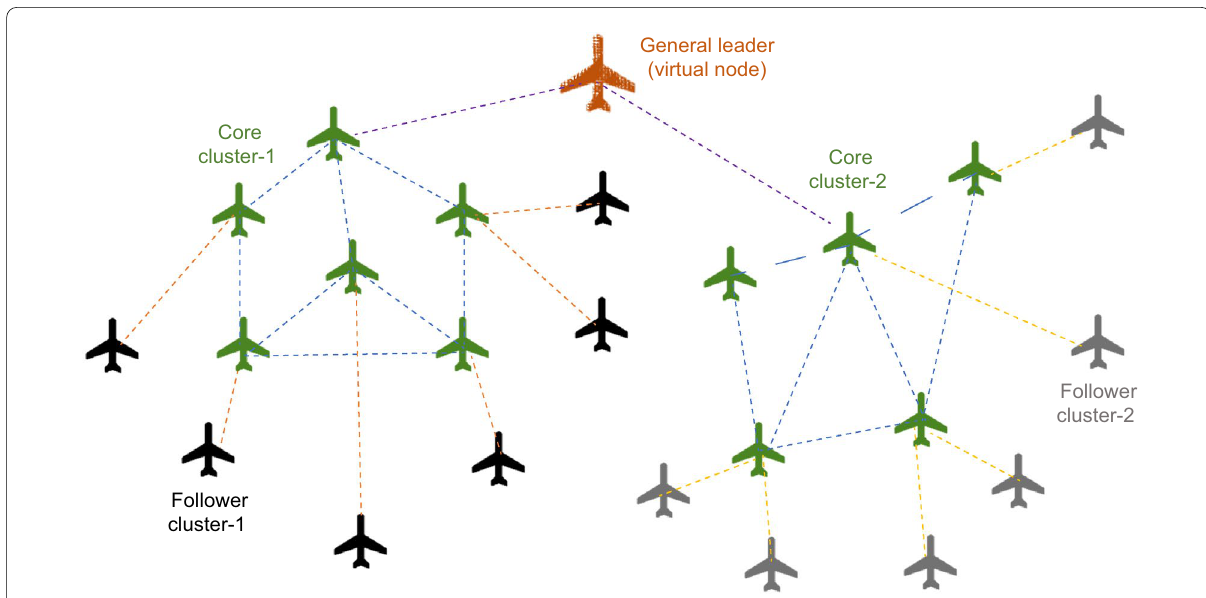
Fig. 1 Cluster hierarchical positioning architecture based on pigeon flock autonomous